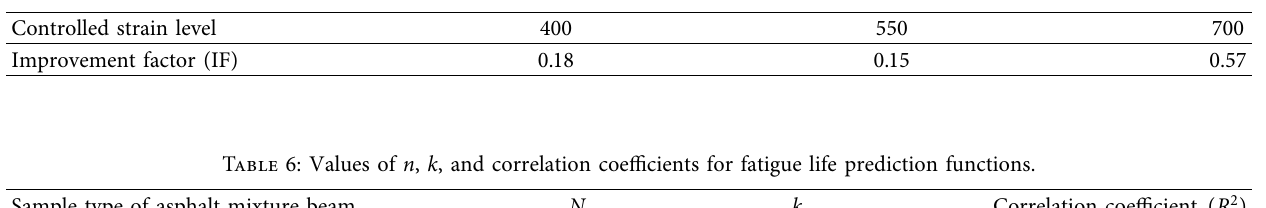
Figure 2: The fatigue life of UMTC and NSMTC specimens at strain levels of 400, 550, and 700 με . Table 5: Improvement factor (IF) for UMTC and NSMTC specimens at 400, 550, and 700 με .